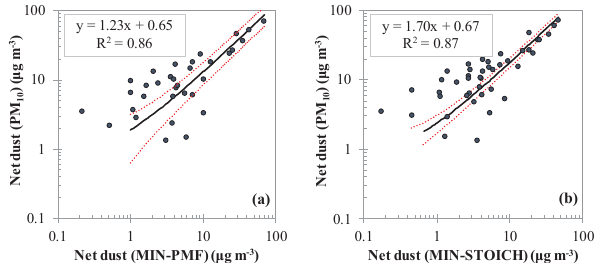
Figure 7. ATHENS: Deming regression analysis of net dust concen- trations calculated from PM 10 regional background concentrations (PM 10 ) versus net dust calculated from (i) the PMF mineral dust contributions to PM 10 (MIN-PMF) (left) and (ii) the PM 10 mineral component (MIN-STOICH) (right). The black line corresponds to the linear regression equation, while the red dotted lines are the up- per and lower bounds, at the 95% confidence interval.